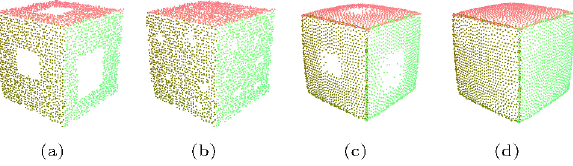
Fig. 20 Filtered results with various holes. (a) Input cube with large holes. (b) Input cube with small holes. (c) Output after filtering (a). (d) Output after filtering (b).